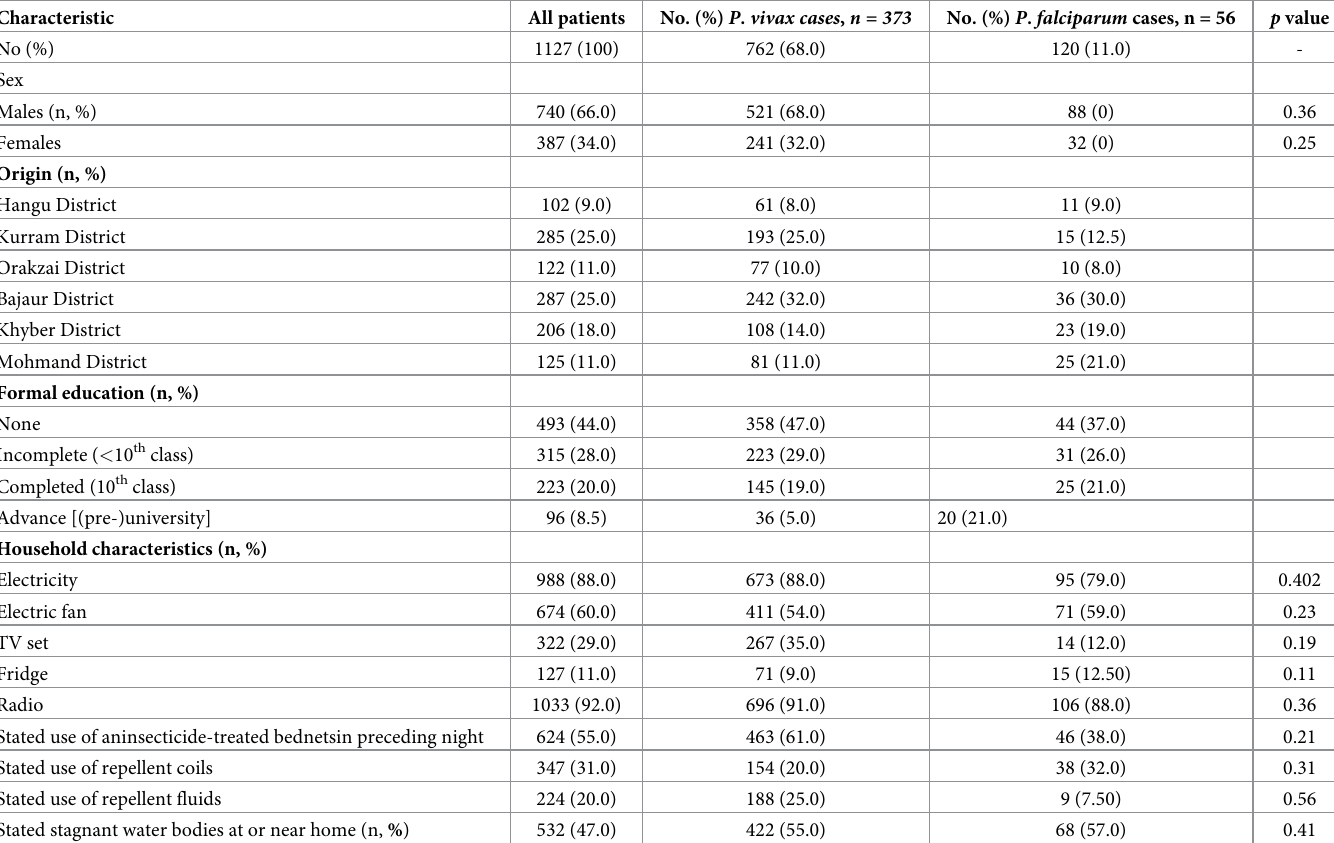
Table 2. Characteristics of 1,127 malaria-suspected patients from tribal districts of KPK,